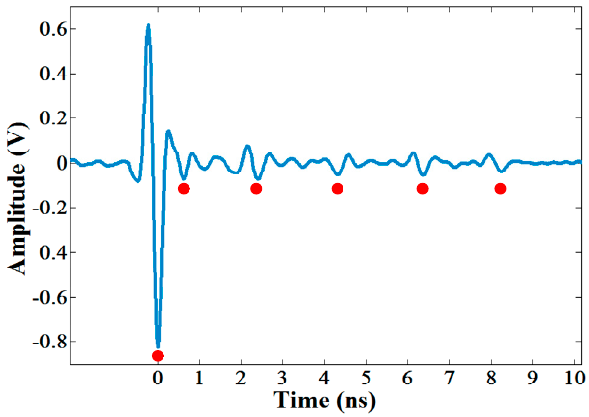
Figure 14. A single trace of the processed GPR data of STR19. The red dots indicate the locations of echoes from six interfaces.